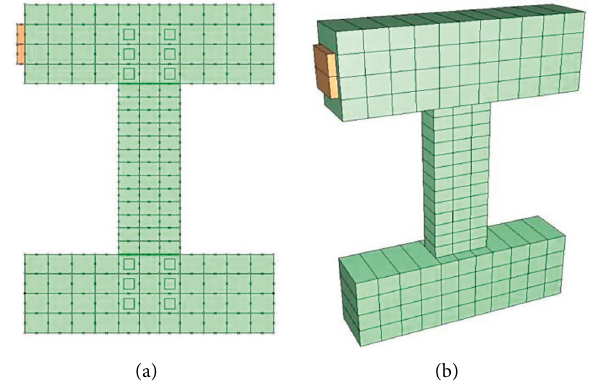
Figure 10: The rebar constitutive model.